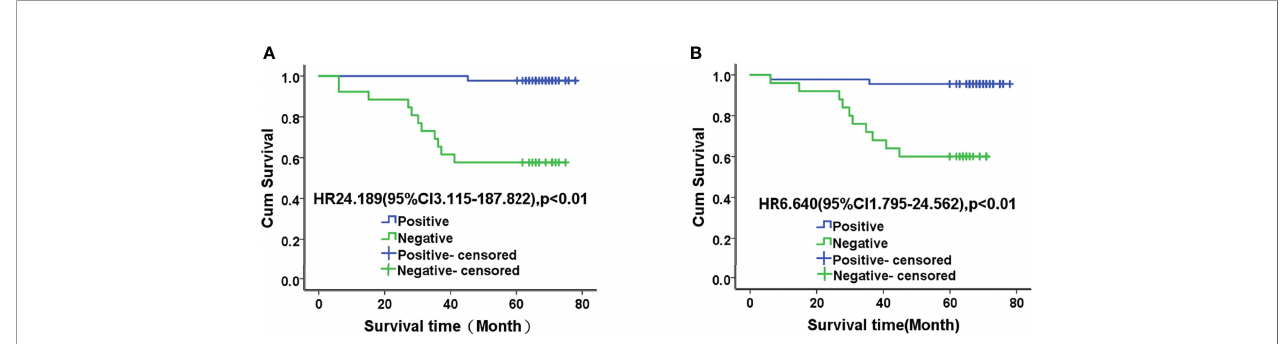
FIGURE 3 | Kaplan-Meier analysis of TET2 (A) and 5-hmC (B) expression and prognosis in patients with endometrial adenocarcinoma. The mean survival time of patients with negative TET2 and 5hmC staining was signi fi cantly shorter than that of patients with positive staining (P <